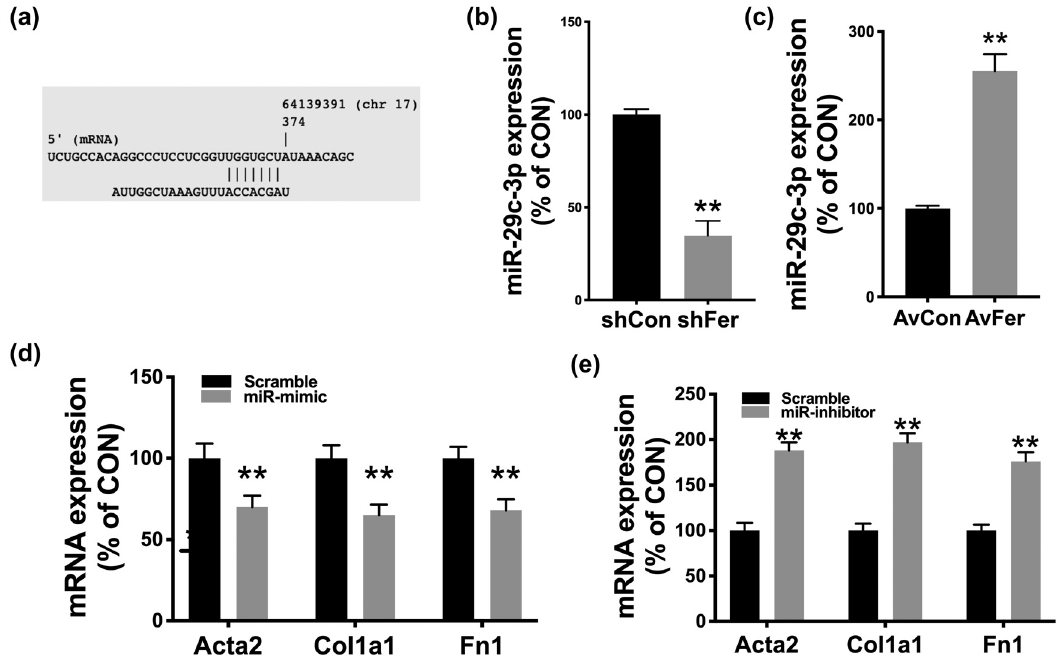
Figure 4: miR - 29c - 3p targets Fer in NRK - 49F cells. ( a ) Binding sequence between miR - 29c - 3p and Fer. Expression of miR - 29c - 3p in cells with or without ( b ) Fer silencing within 48 h of shRNA transfection and ( c ) Fer overexpression within 48 h of adenoviral transfection. Expressions of fi brosis - associated genes in ( d ) miR - 29c - 3p mimic and ( e ) miR - 29c - 3p inhibitor - treated cells, detected 48 h post - treatment ( * P < 0.05; ** P < 0.01 ) .